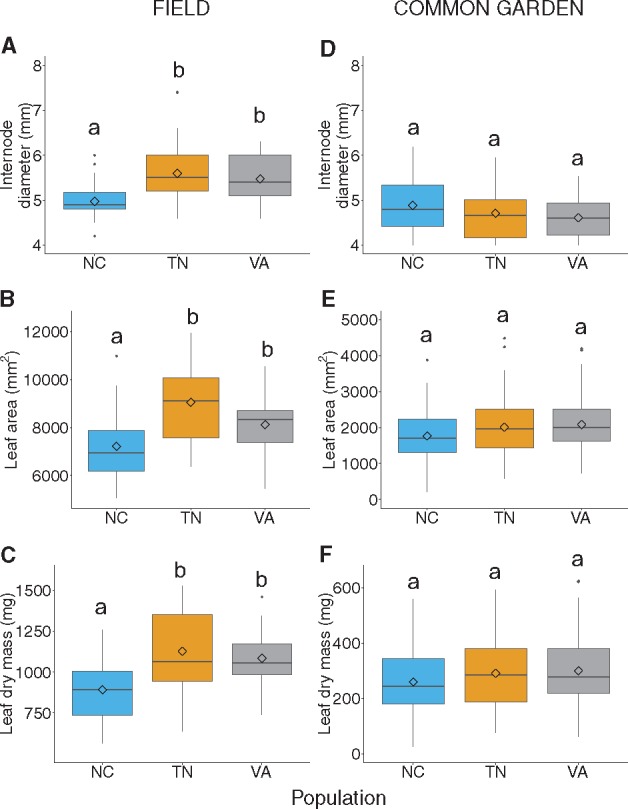
Population means of three traits (internode diameter, leaf area, and leaf dry mass) that differ across Rhododendron maximum populations (North Carolina, NC, blue; Tennessee, TN, orange; Virginia, VA, grey) in field (A–C) and common garden (D–F) environments. Diamond symbols and bold horizontal lines within each box represent the mean and median of the data, respectively; boxes extend to the upper and lower quartile; whiskers extend from each box to the minimum and maximum values of the data, excluding outliers; outliers are shown by black points above or below whiskers. Within each panel, boxes that do not share the same letter are significantly different from each other (Tukey test P < 0.05).